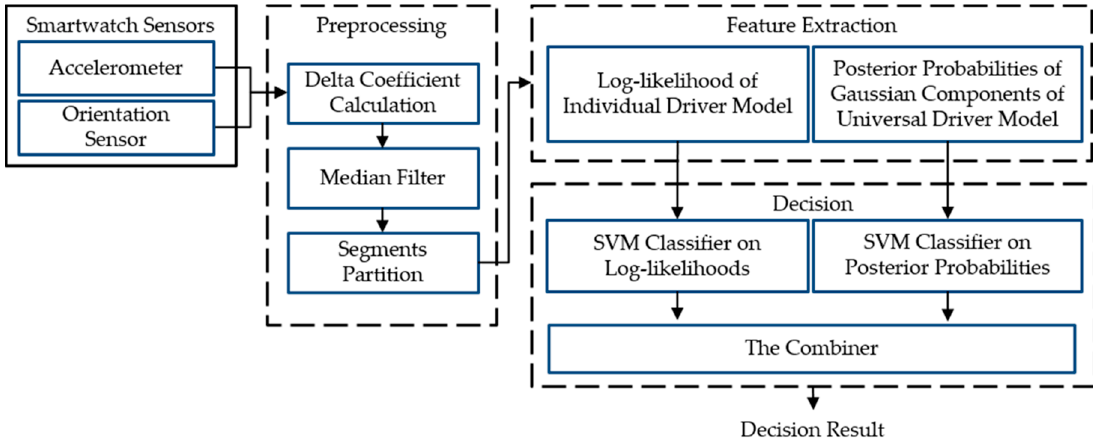
Figure 3. Overview of the proposed smartwatch-based driver authentication mechanism.